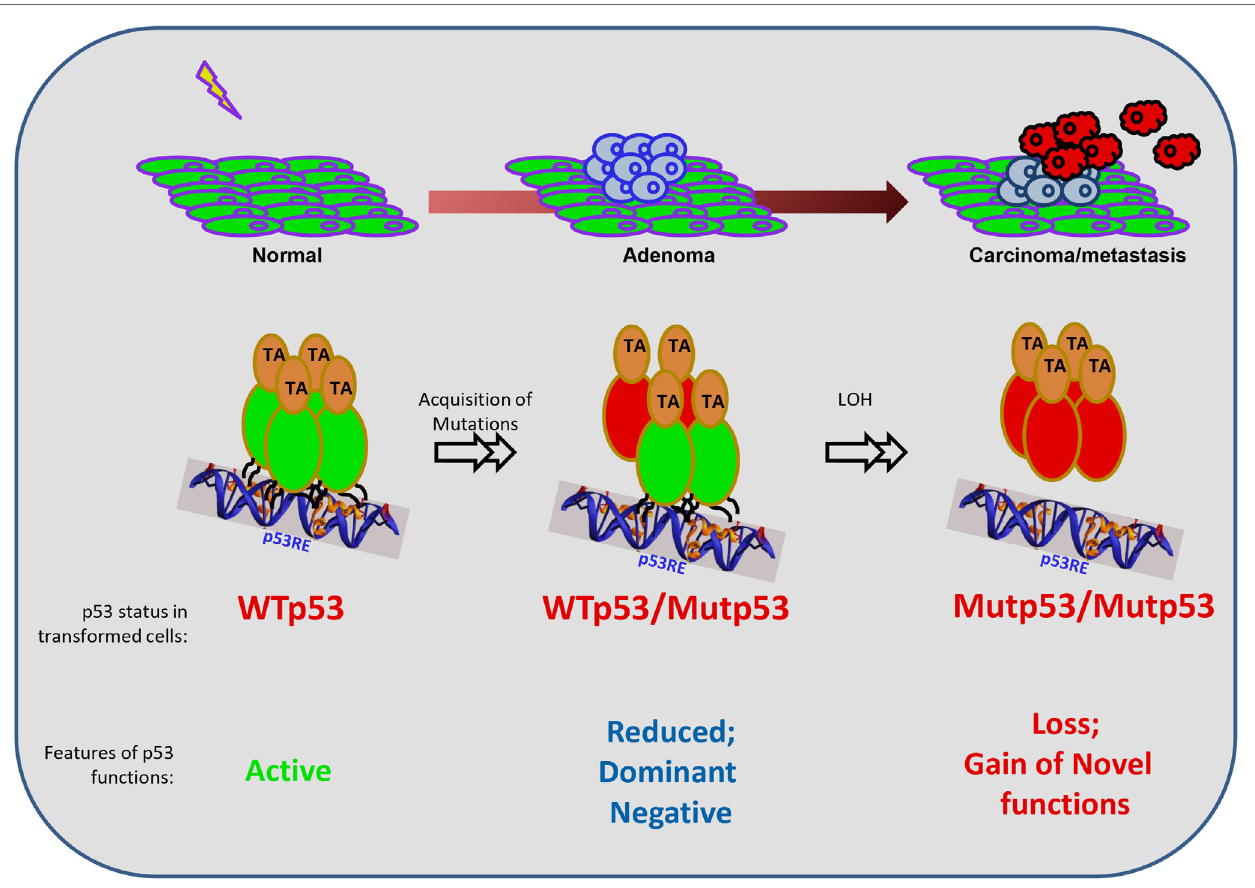
FiGURe 1 | Mutant p53 functions during the evolution of a cancer cell . The schematic represents the general evolution of a normal cell into a transformed cell (carcinoma), and the contexts in which mutant (Mut) p53 exerts its functions. p53 mutations are not present in the normal case and are induced upon genotoxic exposures in one allele. Hence, in the intermediate stage, the mutant p53 co-exists with the wild-type (WT) p53, until the loss of the wild-type allele by loss-of- heterozygozity (LOH). Functionally, when p53 is unmutated, it can be activated and works as a tetramer. However, when one allele is mutated, there is reduced overall function resulting in haploinsufficieny, and also the dominant-negative effect of the mutant protein on the wild-type protein due to the formation of heterodimers (please see text for details). At the later stages when only the mutant p53 remains, it is unable to bind to canonical target sequences to turn on its targets, leading to loss of wild-type functions. In addition, mutant p53 acquires novel gain-of-functions to drive the growth, survival, and invasion of tumor